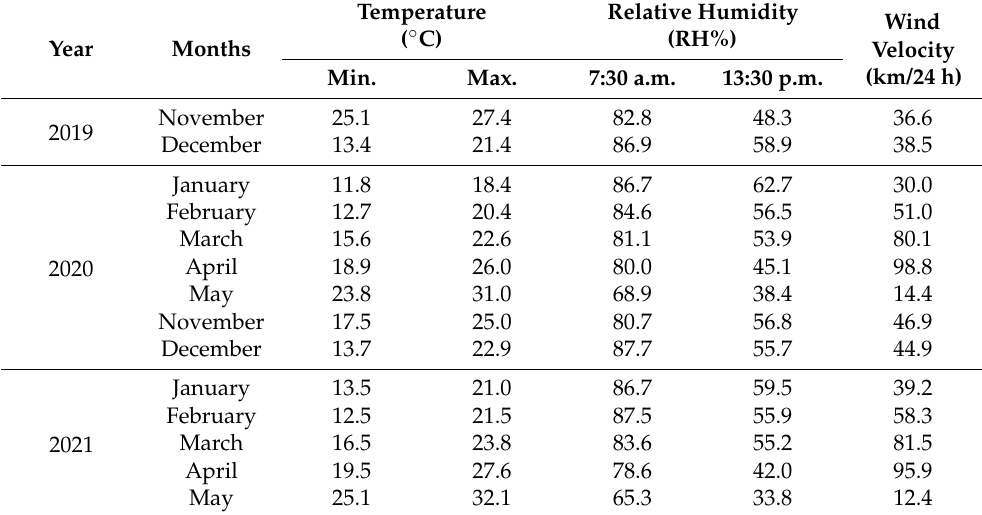
Table 1. The environmental conditions of the experiment during both seasons 2019/2020 and